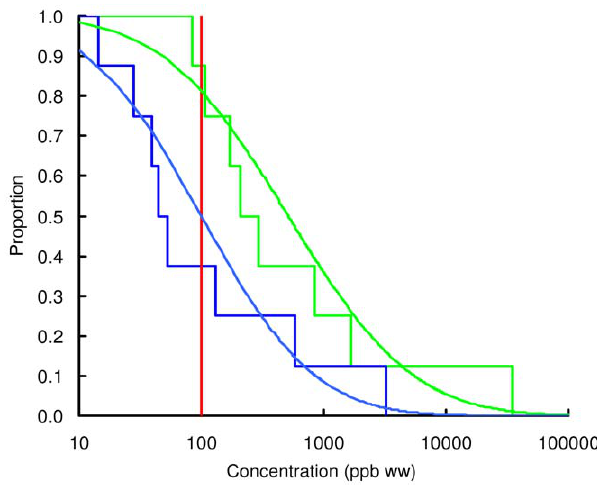
Figure 7. Exceedance distribution of lead concentrations in woodcock. Observed (stepped line) and fitted (curve) exceedance distribution of lead concentrations (ppb wet weight) in woodcock cooked using acidic (green) and non-acidic (blue) methods. The curves represent lognormal distributions fitted to all the data, including those below the limit of quantification, by a maximum-likelihood method involving left-censoring at the LOD/LOQ. The red vertical line shows the statutory maximum residue level (MRL) for poultry and other non-game meat.